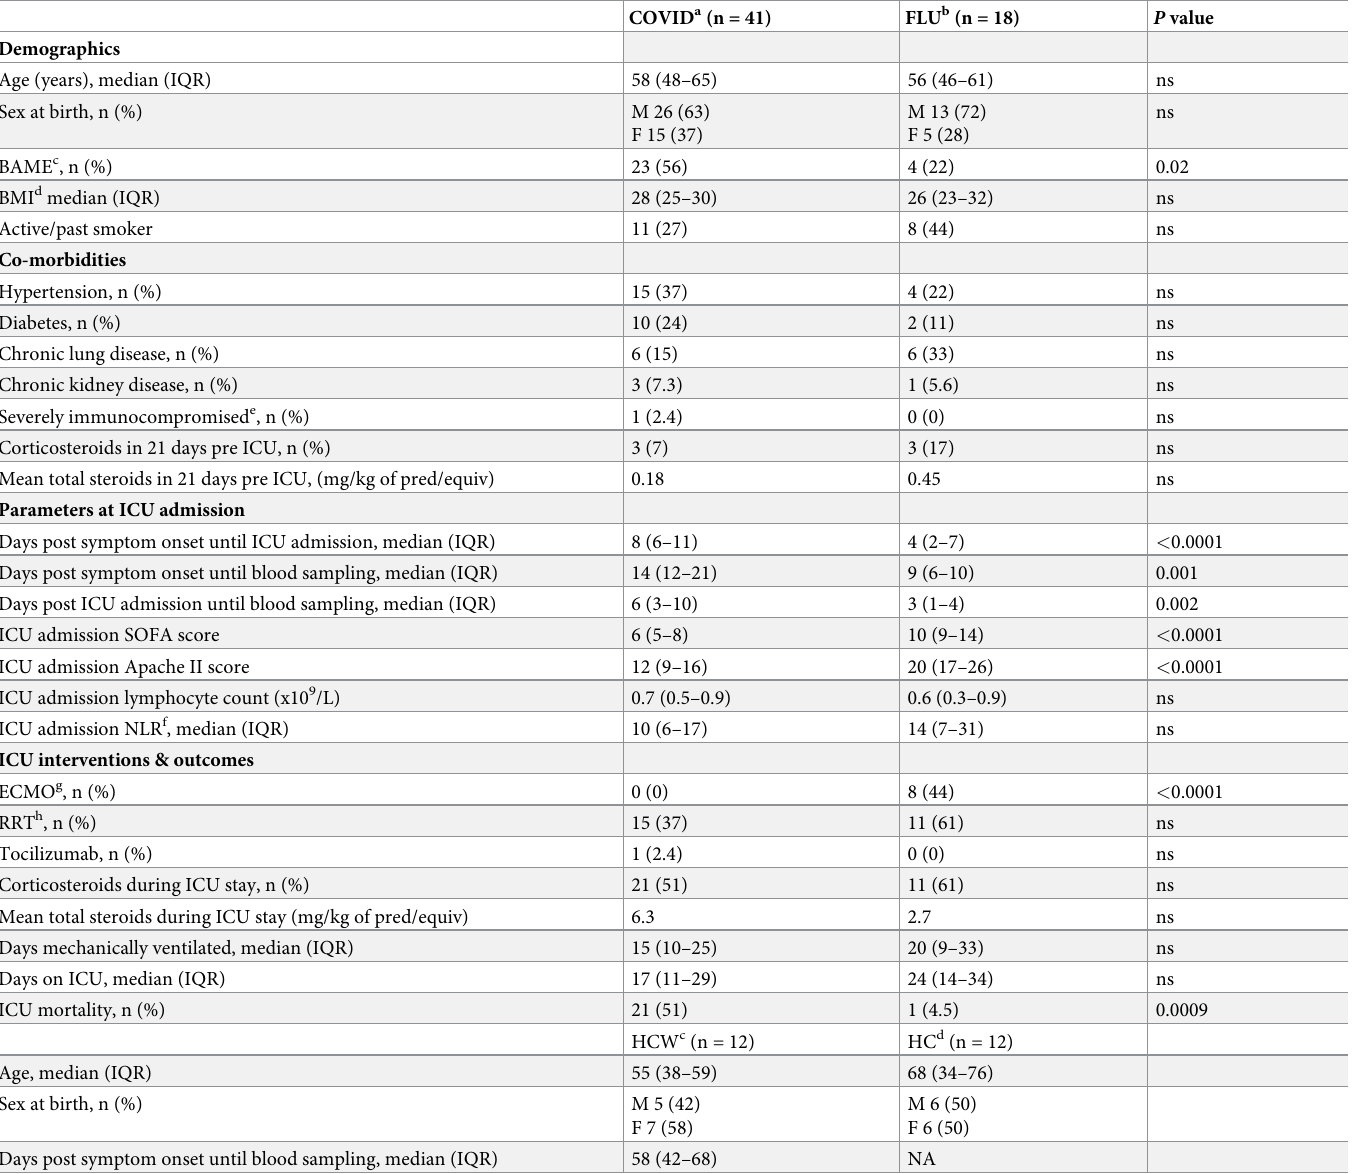
Table 1. Clinical summary of critically ill COVID-19 and influenza